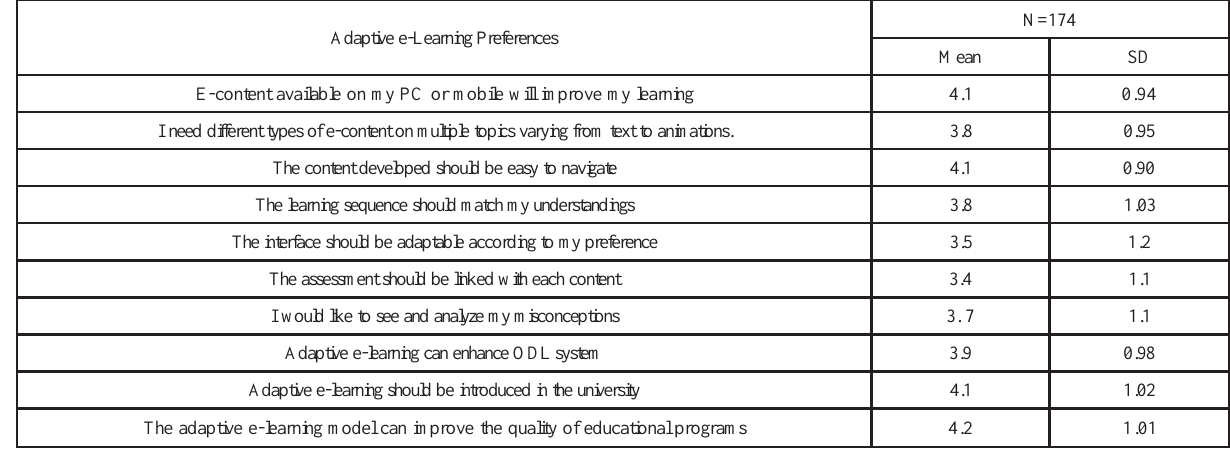
TABLE 2. ADAPTIVE E-LEARNING